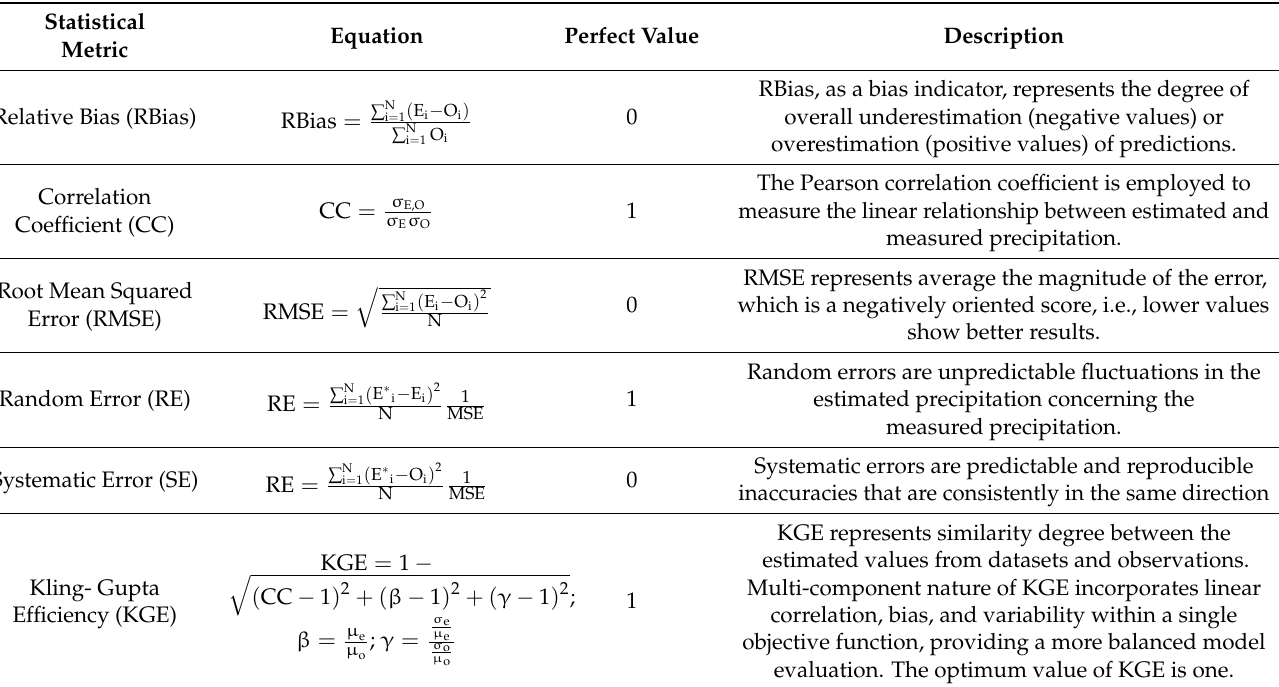
Table 2. Metrics used to evaluate the accuracy of precipitation products and their equations. In these equations, E and O represent the estimated values of precipitation based on products and observed precipitation based on ground stations, respectively, N represents the number of observations, MSE represents the mean square error, E* represents the estimated values of precipitation based on the regression relationship. Linear (aO + b) between precipitation values estimated based on precipitation products and recorded at ground stations. Also, µ and σ represent the mean and standard deviations of the time series, respectively